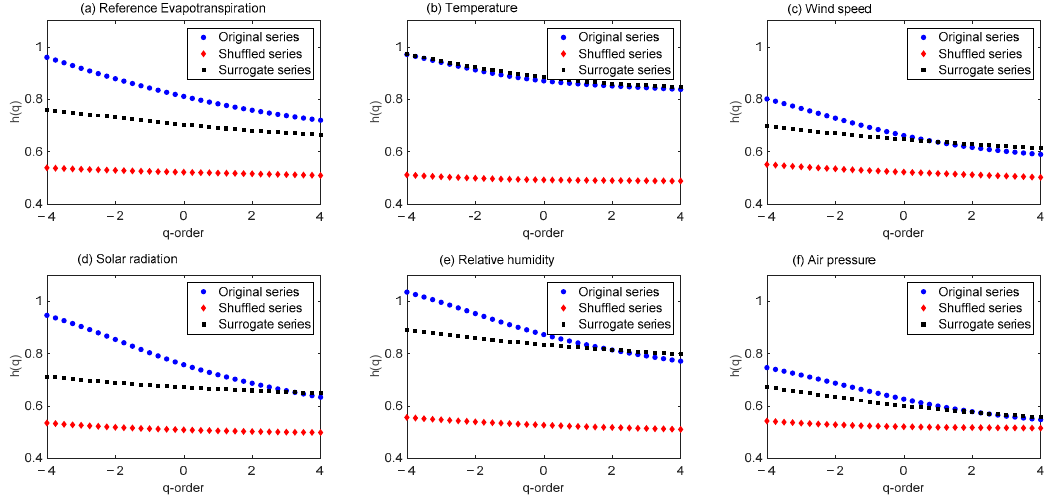
Figure 6. GHE plots of original, shuffled and surrogate series of different agro-meteorological variables of Dagget station: ( a ) reference evapotranspiration; ( b ) temperature; ( c ) wind speed; ( d ) solar radiation; ( e ) relative humidity; and ( f ) air pressure.